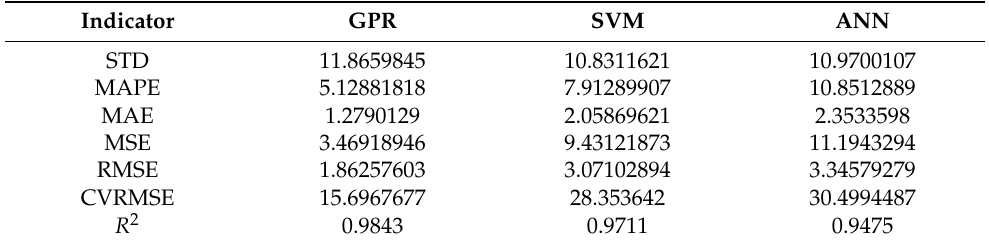
Table 4. Performance measure for the GPR, SVM, and ANN for turning process for AISI 4340.